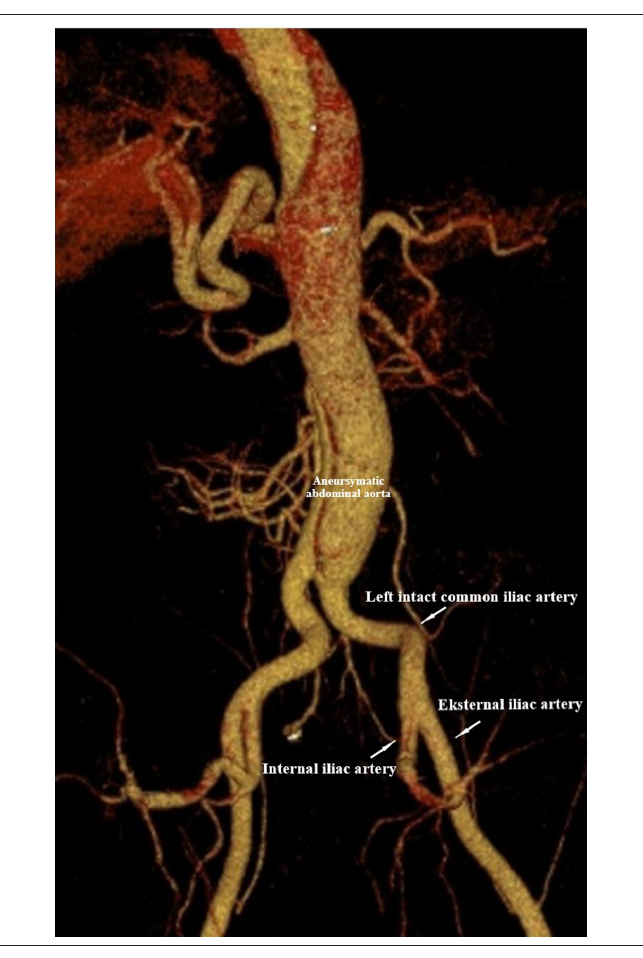
Figure 2. Computerized tomographic angiography; aneursymatic abdominal aorta, left intact common iliac artery, external and internal iliac artery.